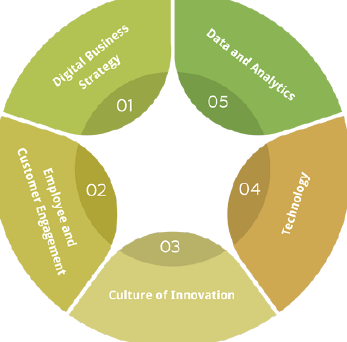
Figure 4. Essential elements of digital transformation technologies [54].